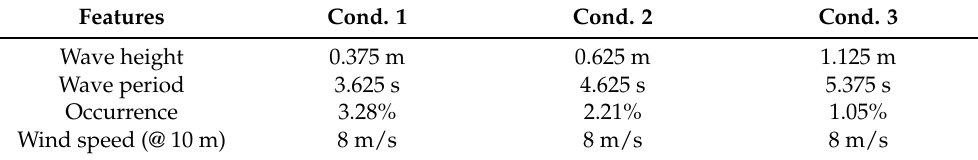
Table 4. Summary of the environmental conditions considered during the